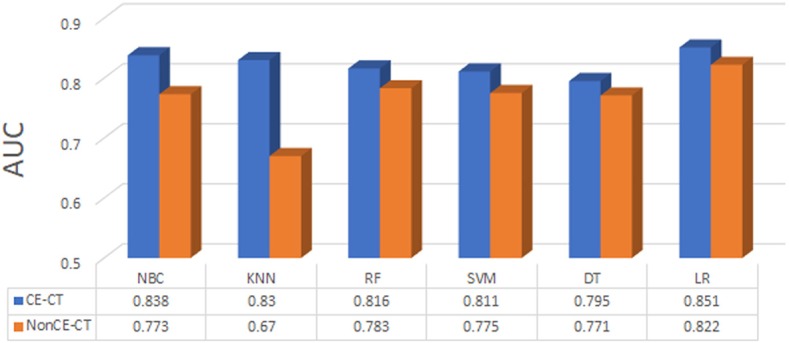
The predictive performance of all machine learning methods based on contrast (CE-CT) and non-contrast (nonCE-CT) data.